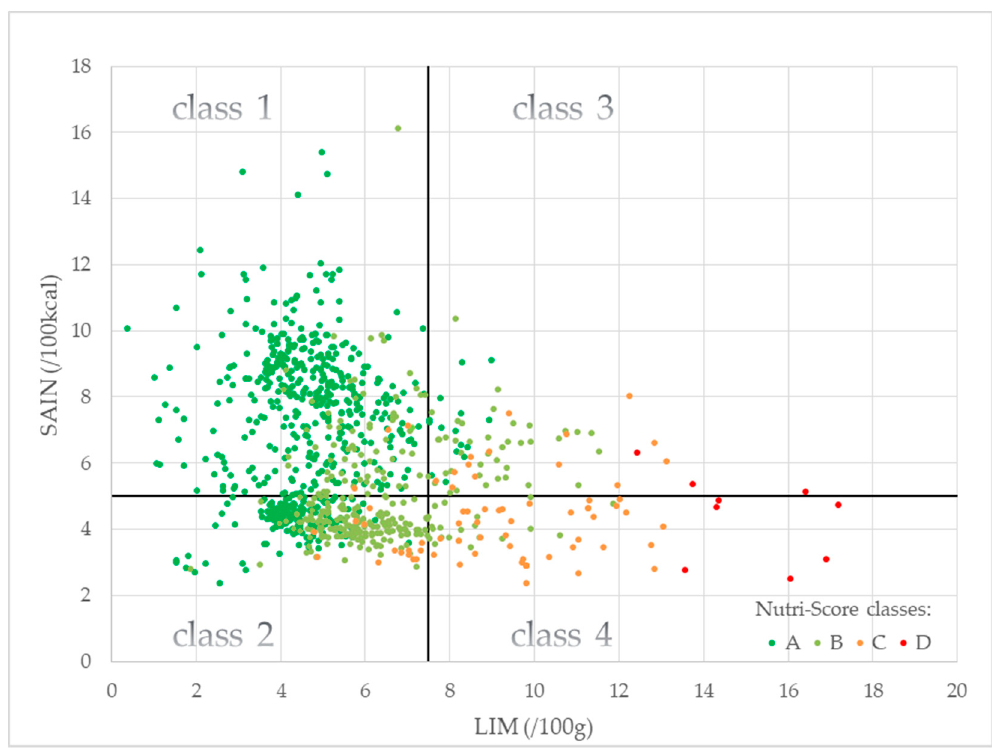
Figure A1. Projection of non-vegetarian and vegetarian main dishes ( n = 984) on the SAIN,LIM plane, represented with the colours of their class according to the Nutri-Score.